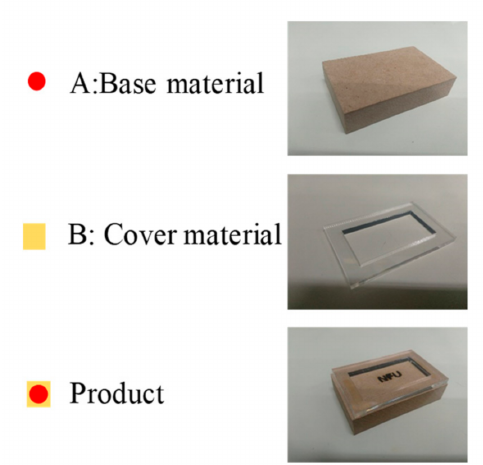
Figure 25. Materials.